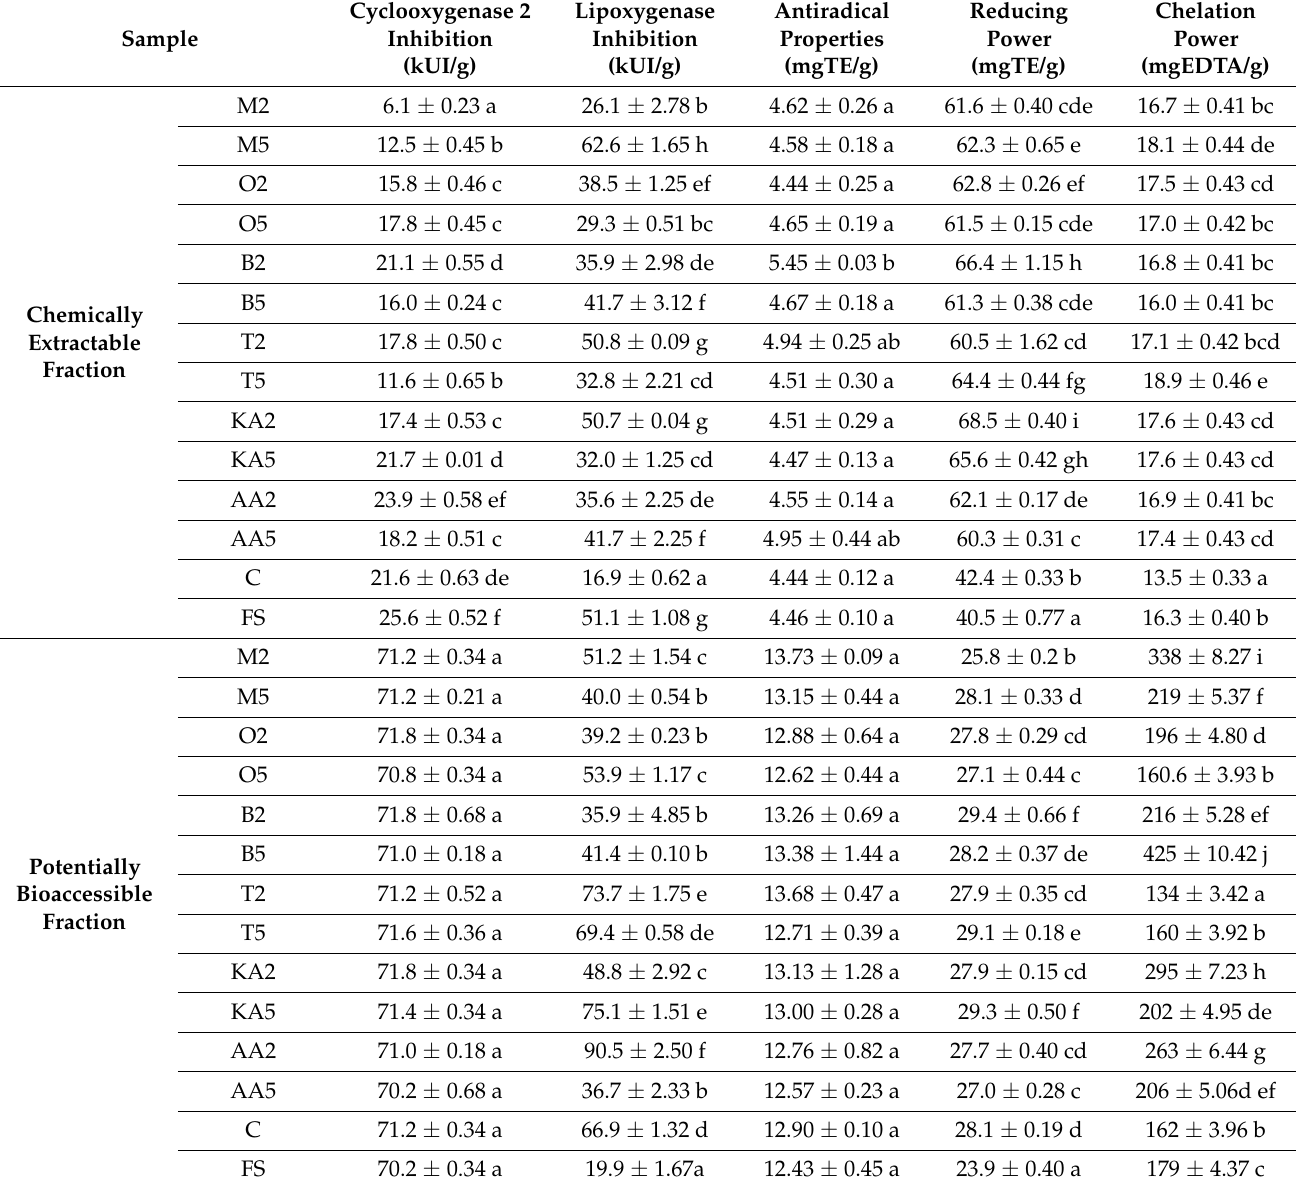
Table 2. Anti-inflammatory and antioxidant properties of mung bean sprouts treated with antibrowning